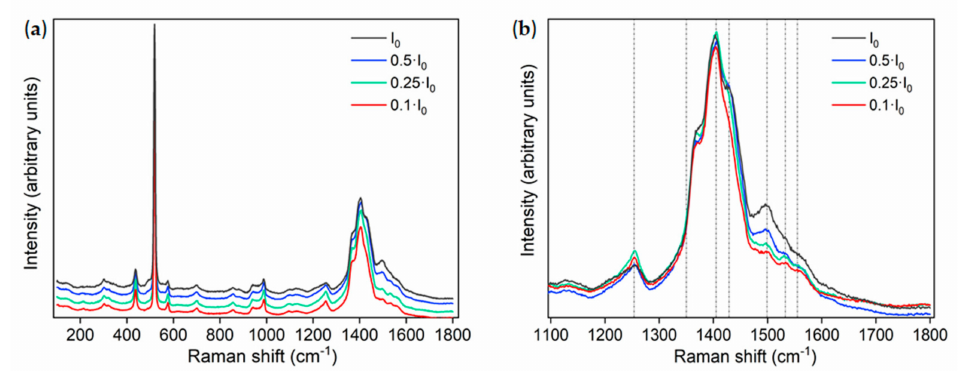
Figure 4. ( a ) Raman spectra acquired on PEDOT:PSS using the UV laser and variable irradiation conditions; ( b ) enlarged region marked in (a) corresponding to the 1100–1800 cm − 1 range.